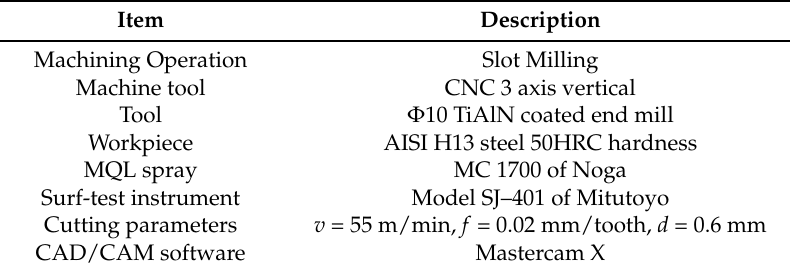
Table 2. Milling process information.